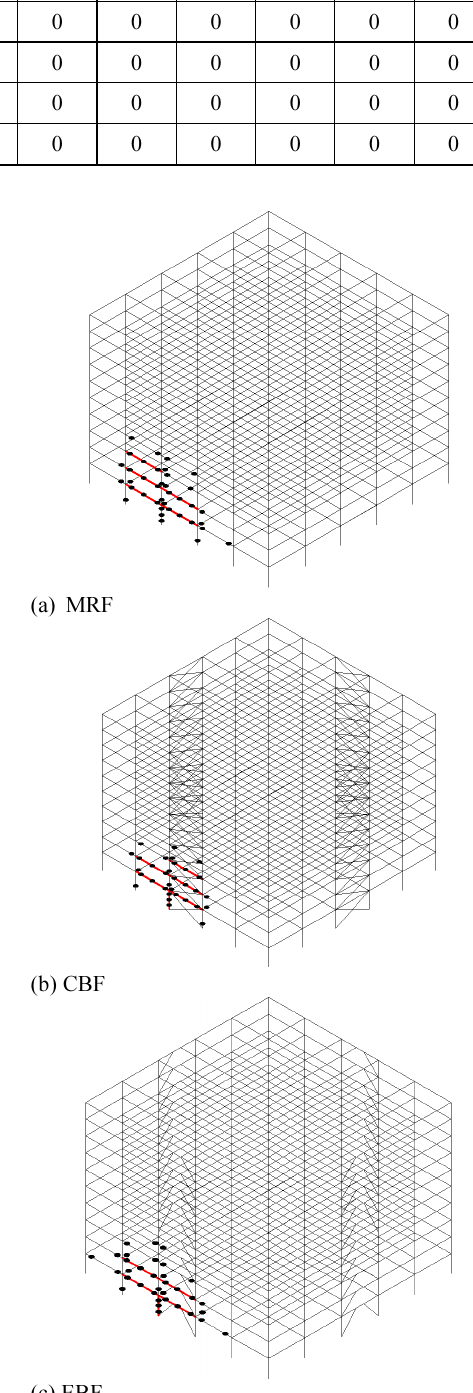
Fig. 10. Plastic hinge locations in MRF, CBF, EBF under a 2-K (8.9 kN) blast (failed member are indicated by a thick